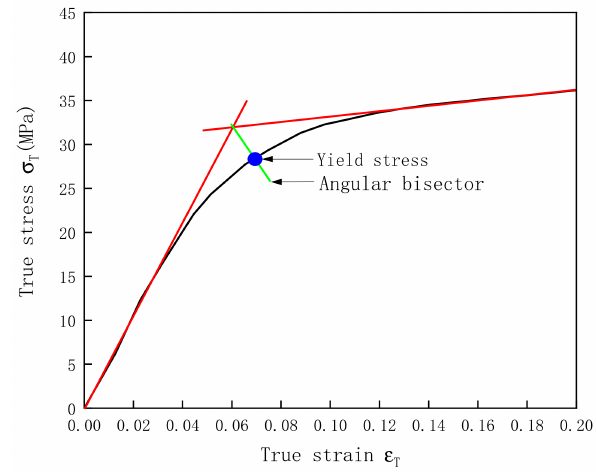
Figure 5. Method to obtain the yield stress of materials.